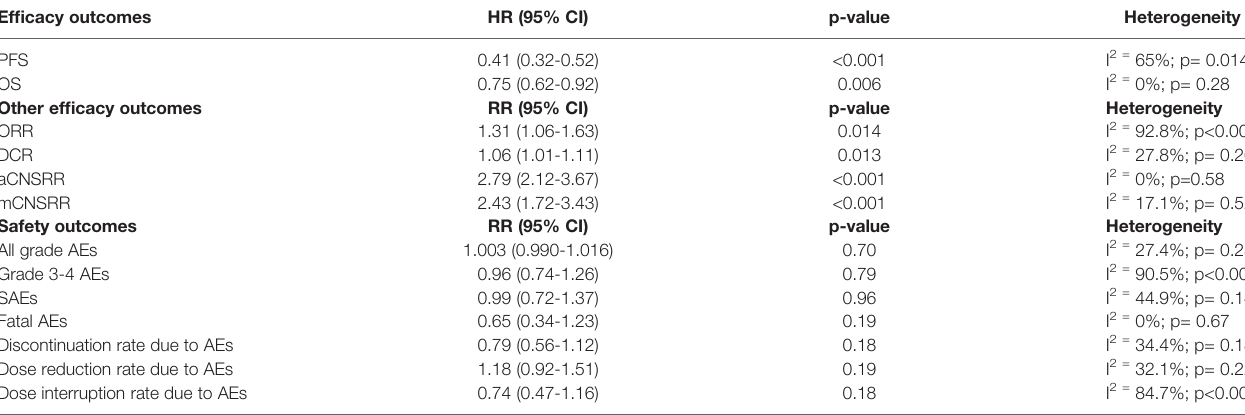
TABLE 3 | Pooled results for the ef fi cacy and safety